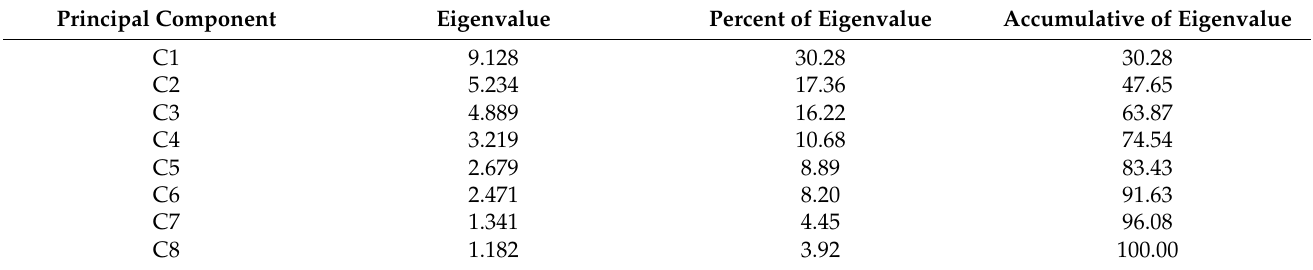
Table 7. Eigenvalues and contribution rates of PCA.